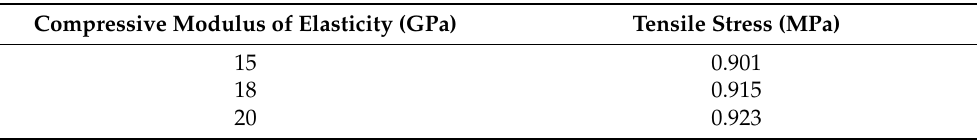
Table 8. Tensile stress corresponding to different Poisson’s ratios and compressive elastic moduli of thick cushion layer cement self-leveling layer. Table 7. Tensile stress corresponding to different Poisson’s ratio and compressive elastic modulus of anhydrite self-leveling mortar